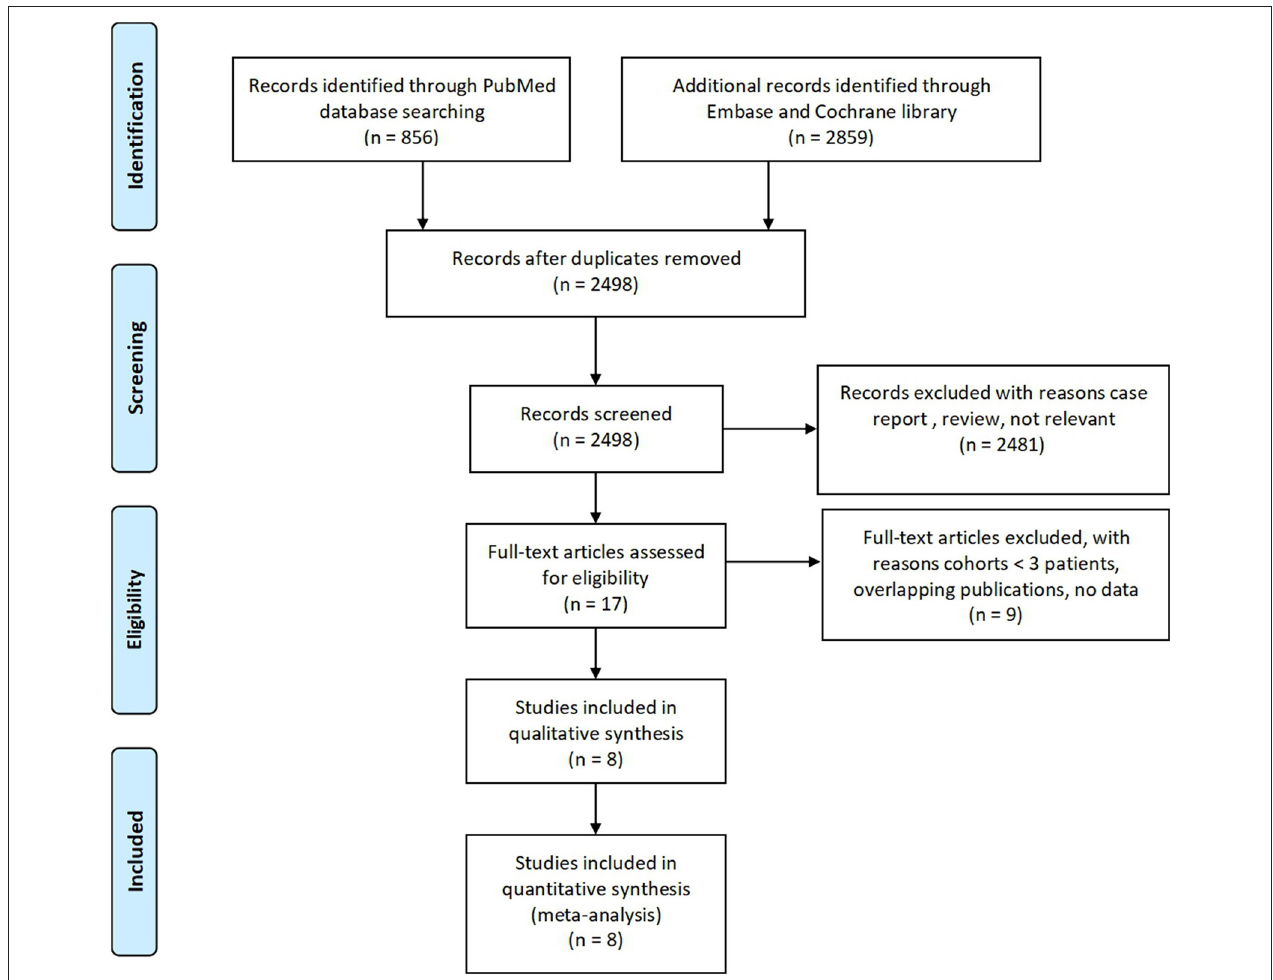
FIGURE 1 | PRISMA flow